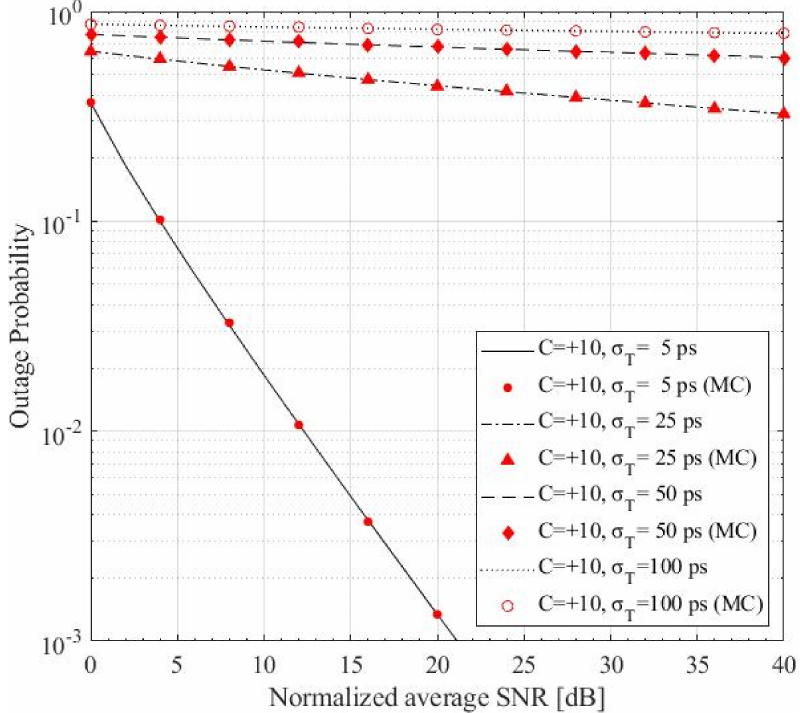
Figure 6. Outage probability of a 100 Mbps link as a function of the normalized average SNR, γ j / γ j , th , with T 0 = 10 ps, as detected after 10 km propagation distance. The illustrated curves are successfully contrasted with the Monte Carlo method with 10 7 steps, indicated by the corresponding red